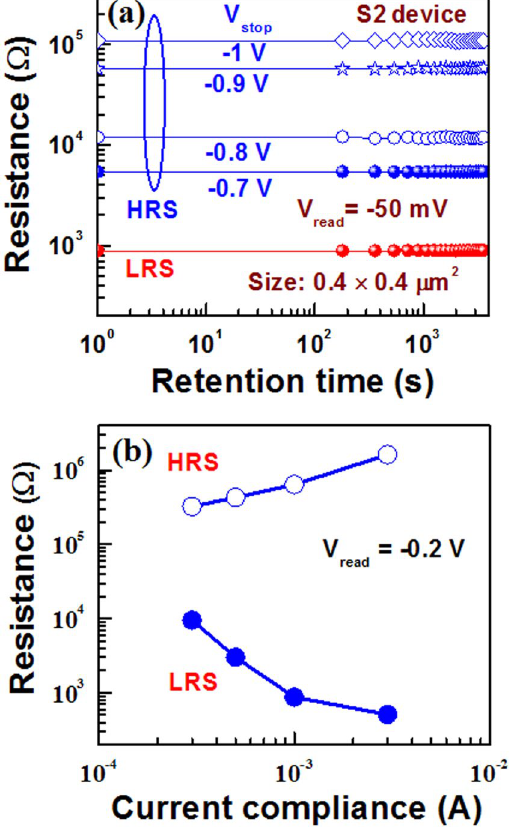
Figure 8. ( a ) Data retention for multi- levels corresponding to stop voltages of − 0.7 V, − 0.8 V, − 0.9 V and − 1 V. ( b ) Current compliance dependent multi-level resistance changes in both LRS and